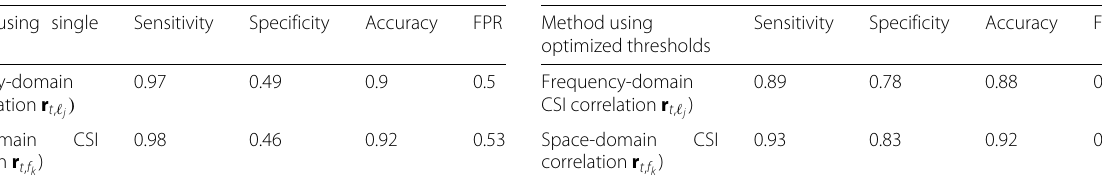
Table 4 Performance evaluation of target detection with measurements related to a single and double target moving along the main LOS path (connecting TX and RX2); both space- and frequency-domain correlation methods with optimized thresholds are